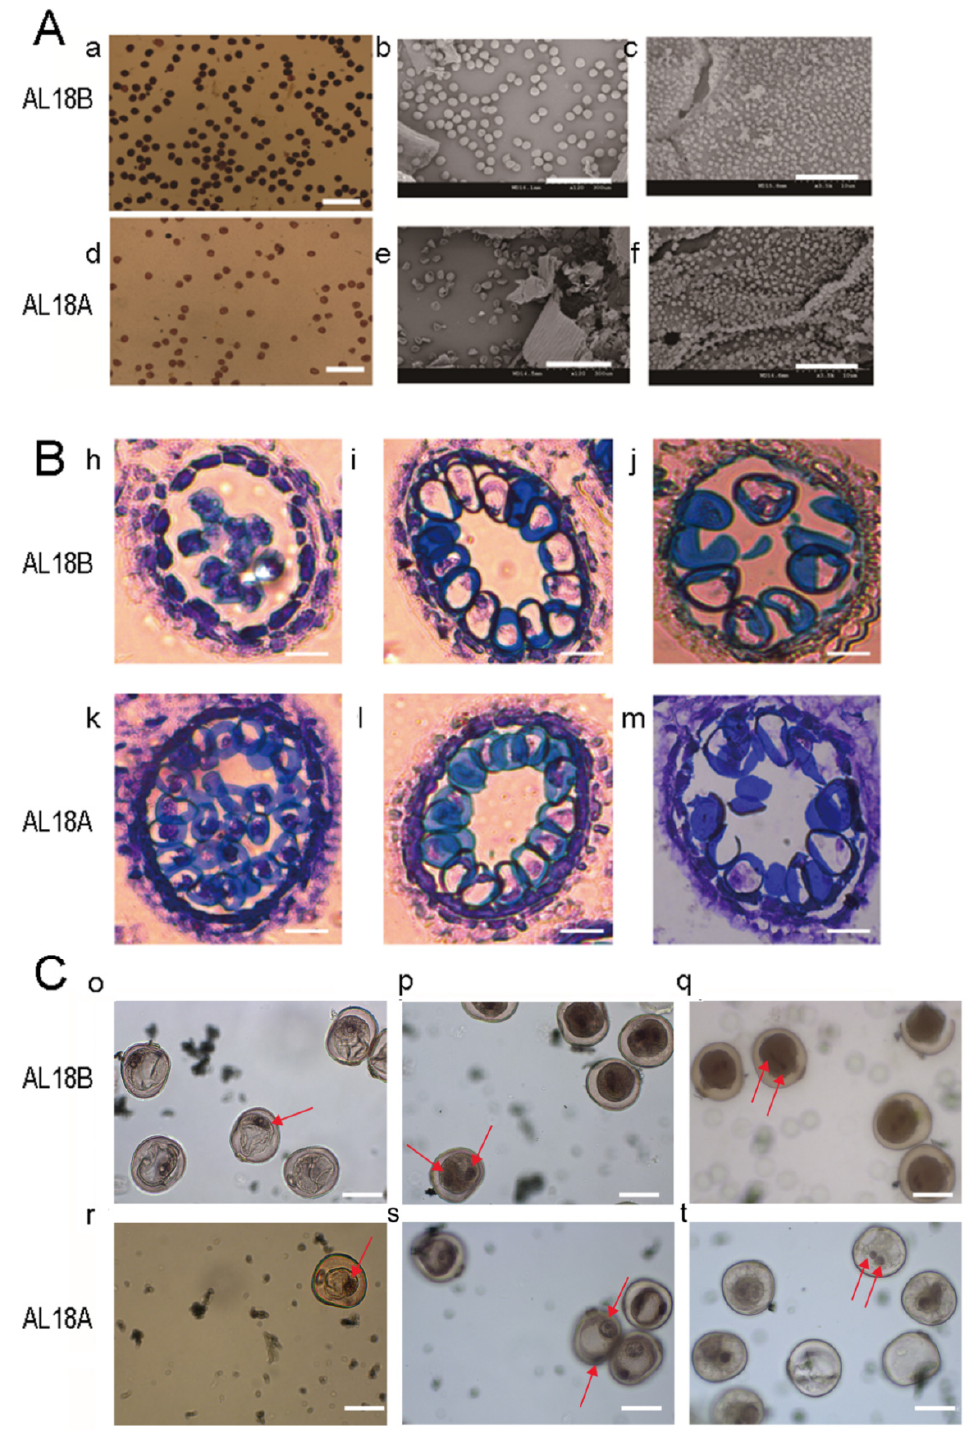
Figure 1. Comparison of anther and pollen grains of AL18B and AL18A. ( A ), (a,d) Mature pollen grains of AL18B and AL18A stained with I 2 -KI (Scale bar: 200 µ m); (b,e) Mature pollen grains of AL18B and AL18A (Scale bar: 300 µ m); (c,f) Tapetal cell surface-localized orbicule (Or) structures of AL18B and AL18A (Scale bars: 10 µ m). ( B ), (h,i,j) Paraffin sections of early-uninucleate, later-uninucleate, and binucleate stage of AL18B. (k,l,m) Paraffin sections of early-uninucleate, later-uninucleate, and binucleate stage of AL18A (Scale bars: 10 μ m). ( C ), (o–q) Carmine acetate dyeing of pollen in uninucleate, early-binucleate, and later- binucleate stage of AL18B. (r–t) Carmine acetate dyeing of pollen in uninucleate, early-binucleate, and later- binucleate stage of AL18A, red arrows indicate nucleus. (Scale bars: 30 μ m).